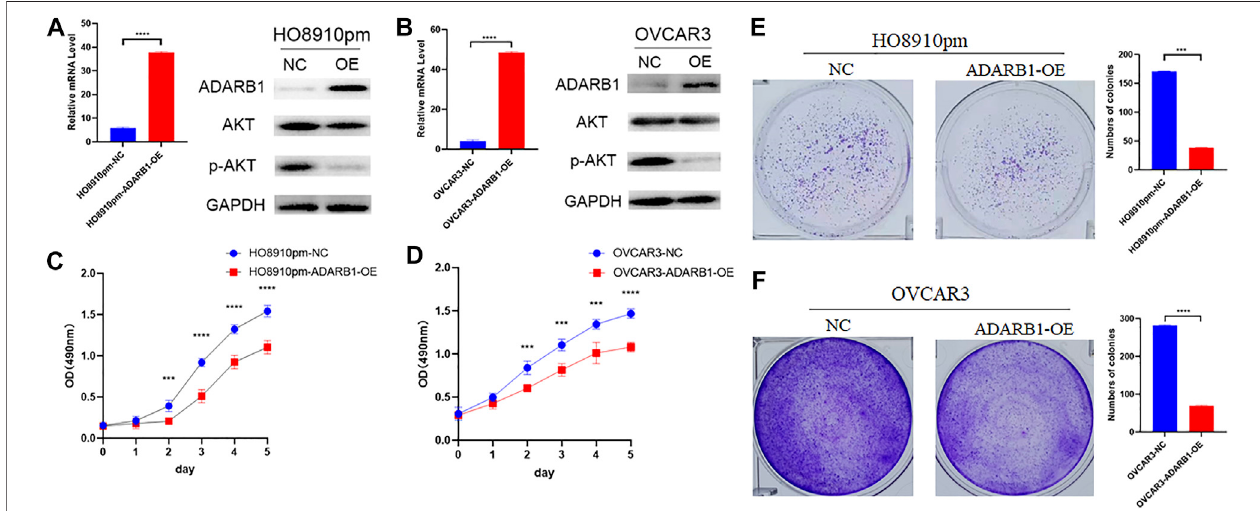
FIGURE 3 | Overexpession of ADARB1 suppressed the proliferation ability of OC cells. (A,B) The mRNA levels of ADARB1 after transfected with ADARB1-OE in HO8910pm and OVCAR3 cells. (C,D) The results of MTT assay after transfected with ADARB1-OE in HO8910pm and OVCAR3 cells. (E,F) The results of colony formation assay after transfected with ADARB1-OE in HO8910pm and OVCAR3 cells.